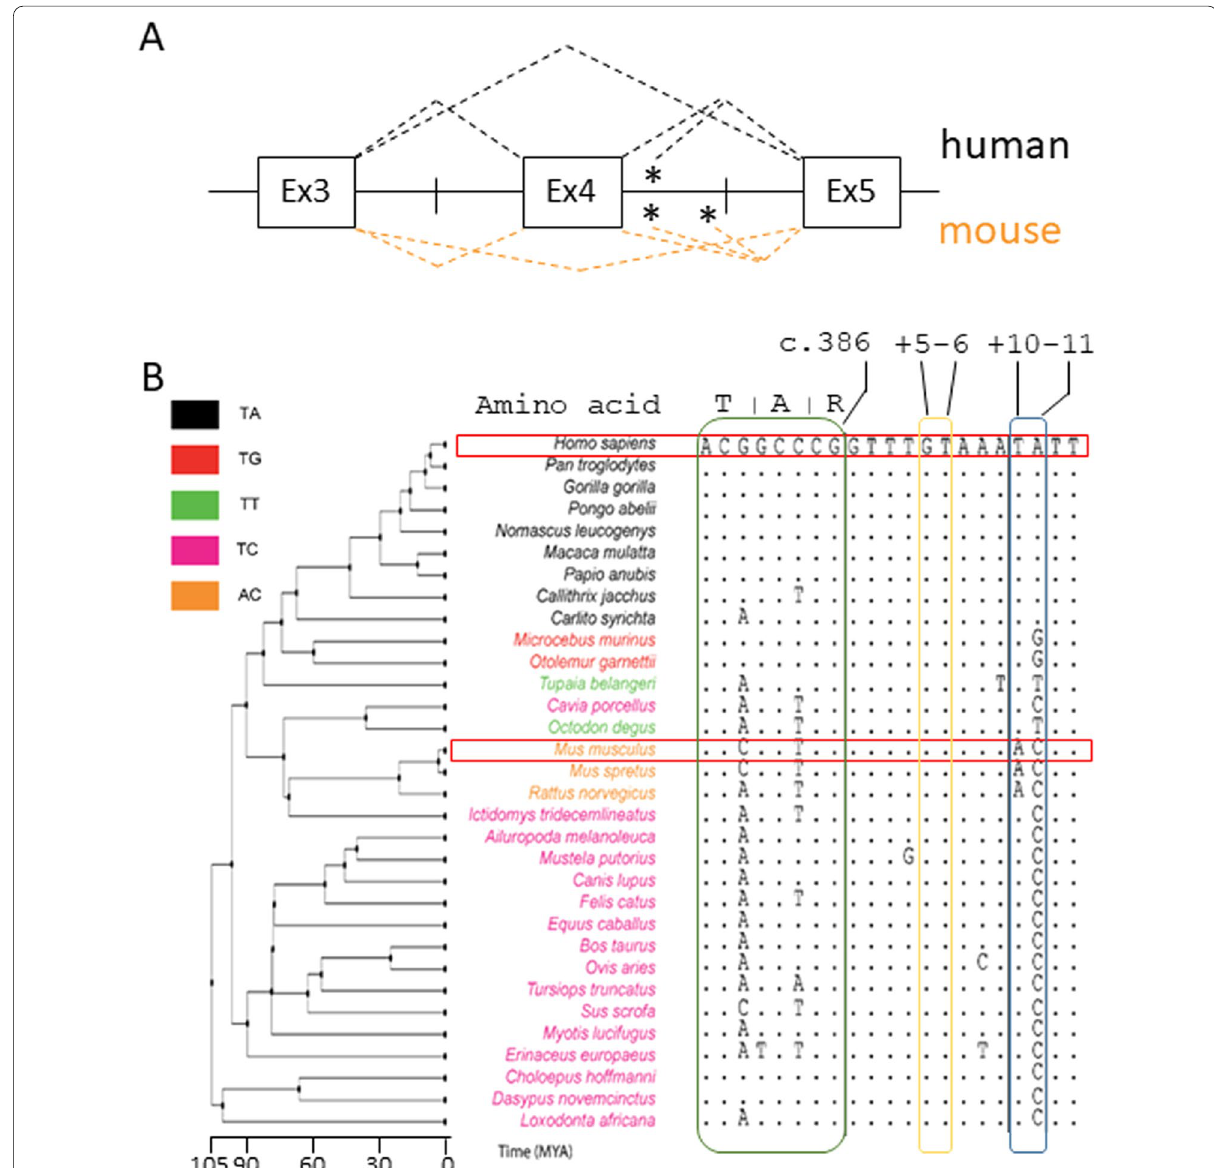
Fig. 1 Species-specific splicing patterns and comparative sequence alignment of OTC exon 4 sequences. A Schematic representation of the OTC pre-mRNA focused on exon 4, with exons and introns indicated by boxes and lines, and of the alternative splicing events triggered by the c.386G>A mutation in the human and mouse context. Asterisks indicate cryptic 5 ′ ss. B Multiple sequences alignment of the OTC exon 4 5 ′ ss and the downstream region. The human sequence has been used as reference. Dots represents conserved nucleotide. The human and mouse sequences are included within red boxes. Exon 4 and nucleotides at position 10-11 are included within green and blue boxes, respectively. The cryptic 5 ′ ss + is highlighted by the yellow box. The phylogenetic tree, together with years (millions of years, MYA) of species separation, is reported on the left. Colors indicate the type of nucleotide couple at position +